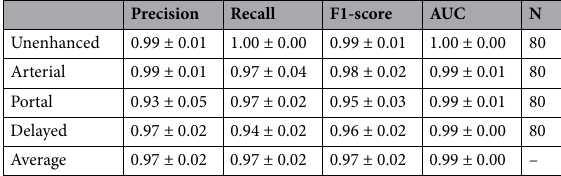
Table 6. Performance metrics in the testing set for the volumes evaluation using cross validation. The values are mean ± standard deviation.